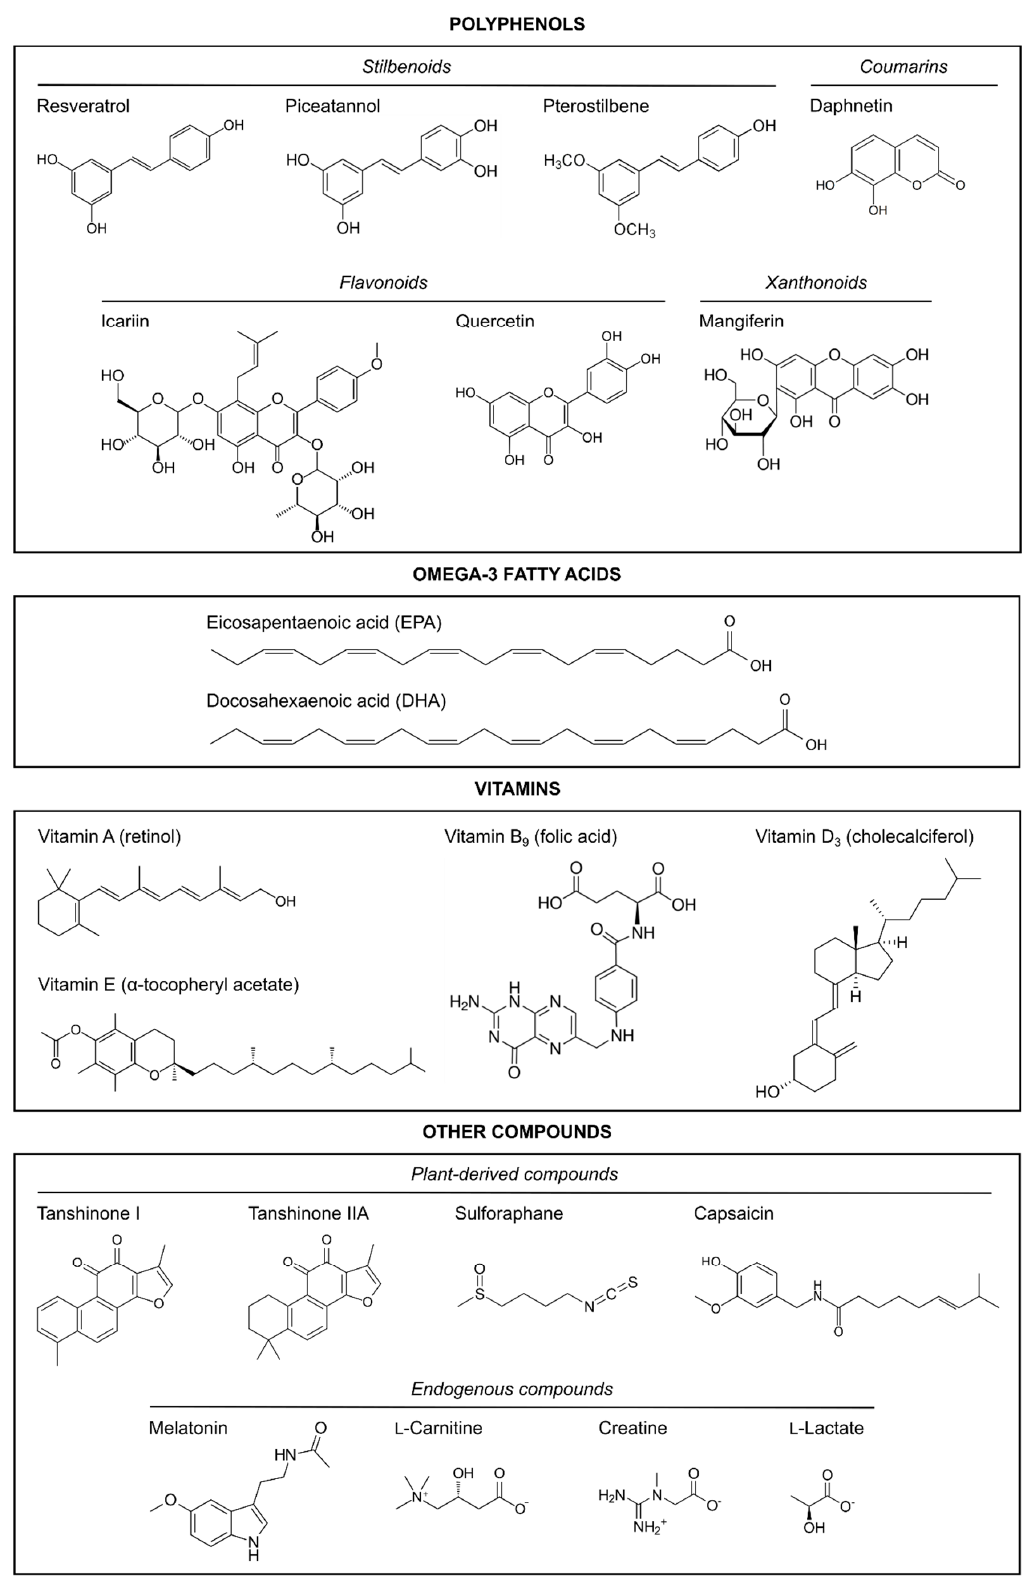
Figure 1. Chemical structures of the natural neuroprotective compounds reviewed here.